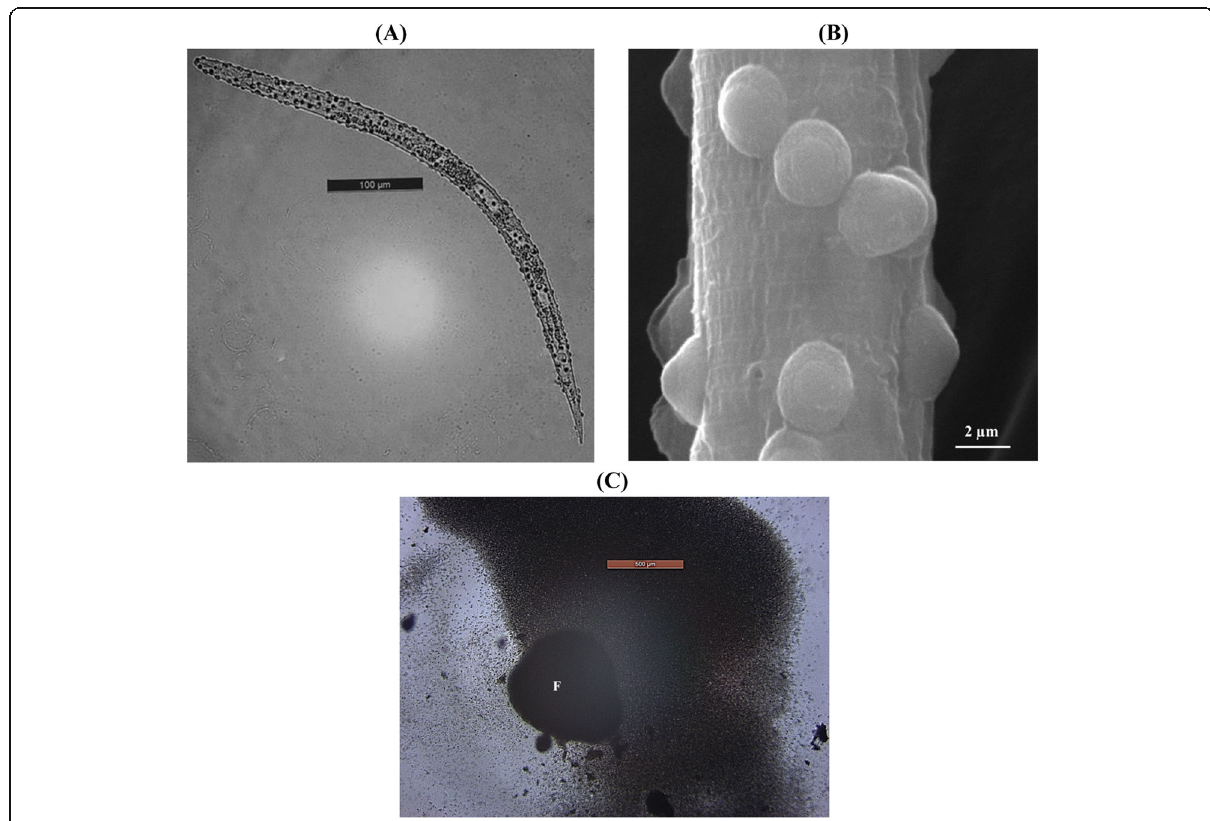
Fig. 2 Pasteuria attachment and reproduction on Meloidogyne incognita . Light micrograph ( a ) and scanning electron micrograph ( b ) of Pasteuria endospore attachment to the cuticle of second-stage juvenile of Meloidogyne incognita . Light micrograph of crushed infected root-knot nematode female with released Pasteuria endospores ( c